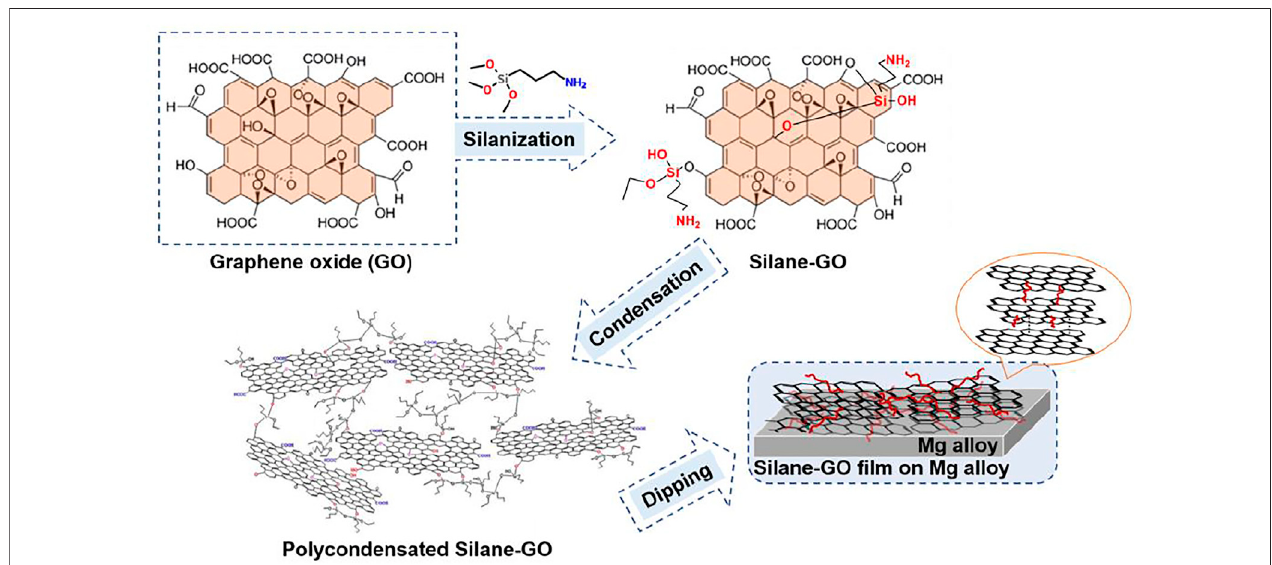
FIGURE 1 | Schematic representation of the synthesis and silanization of GO and the preparation of silane-GO fi lms on the Mg alloy.